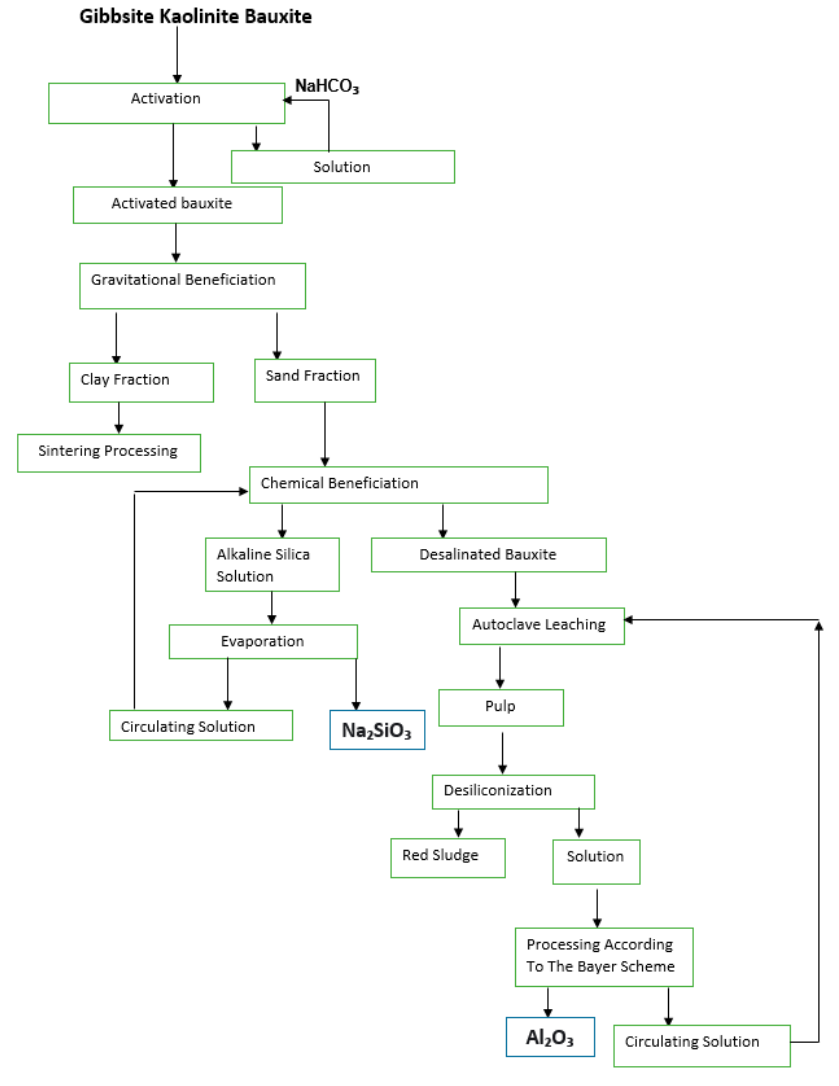
Figure 1. Two-stage beneficiation technology of bauxites.